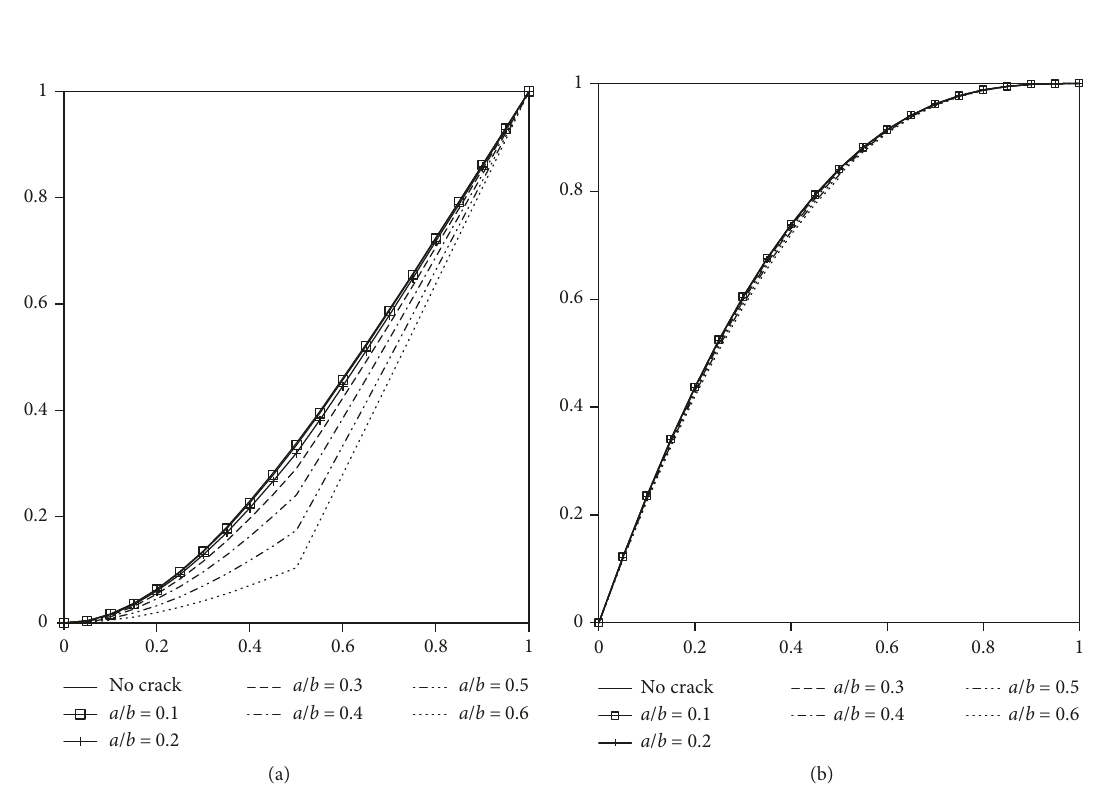
Figure 5: First mode: (a) bending and (b) torsion of a composite beam with a crack located at 50% span and unidirectional ply angle of 70 ° .